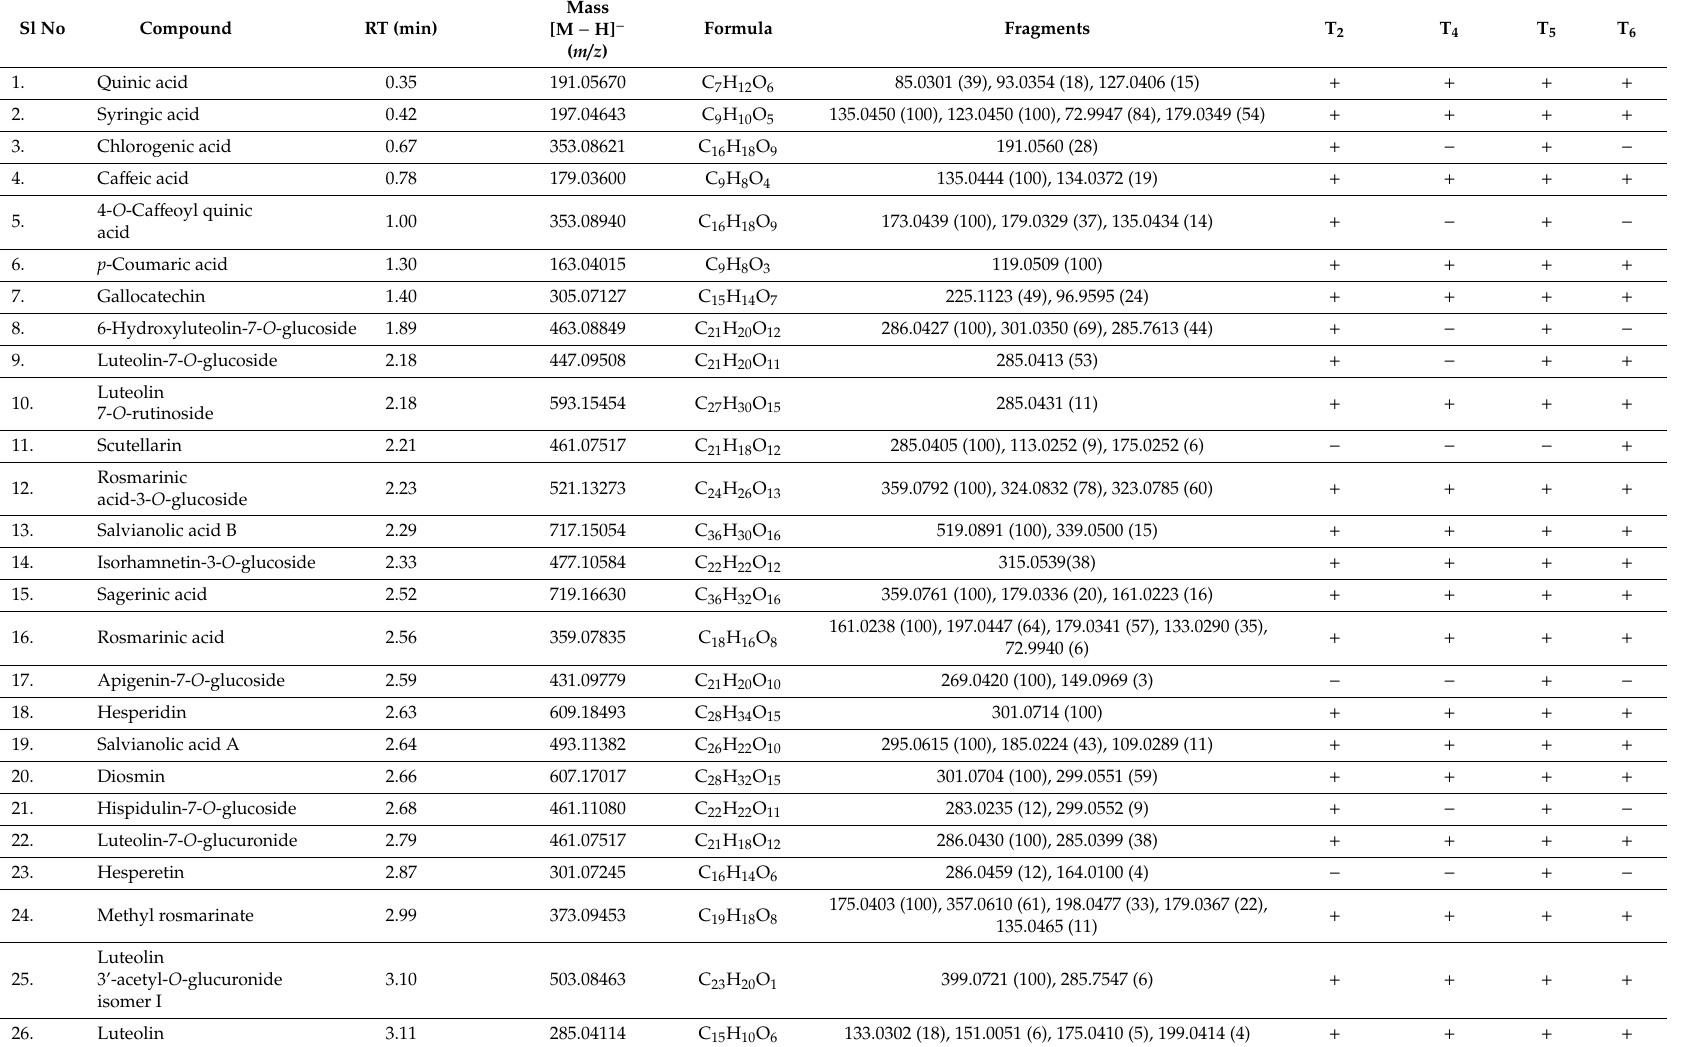
Table 3. Analysis of bioactive compounds in fresh leaf (T 2 ) and dry leaf decoction (T 5 ) and their respective fermented extracts (T 4 and T 6 ) of R. o ffi cinalis by